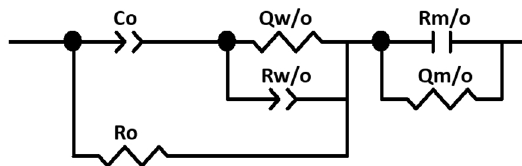
Figure 2. Equivalent circuit for AISI 1020 steel in heavy, medium and blend crude